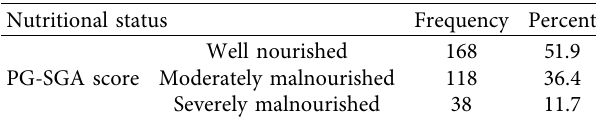
Table 3: Nutritional status of adult cancer patients undertaking chemotherapy treatment at HUCSH, Hawassa, Southern Ethiopia.